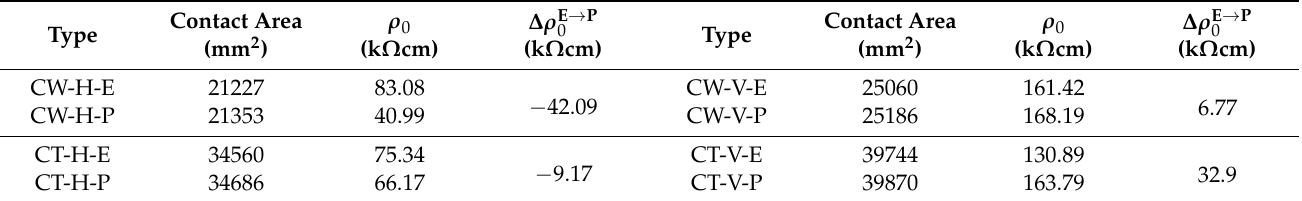
Table 5. Electrical parameters of SCA under